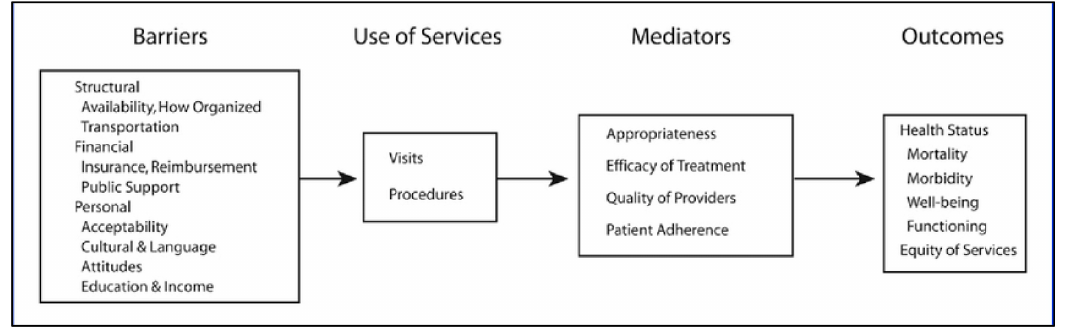
Figure 1. Model of access to personal health care services